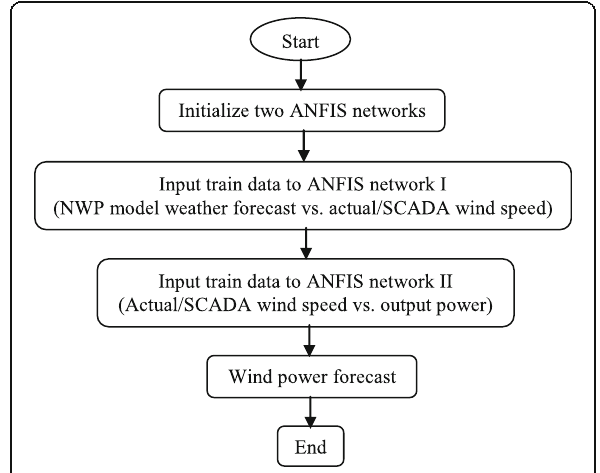
Fig. 3 Double-stage ANFIS wind power prediction